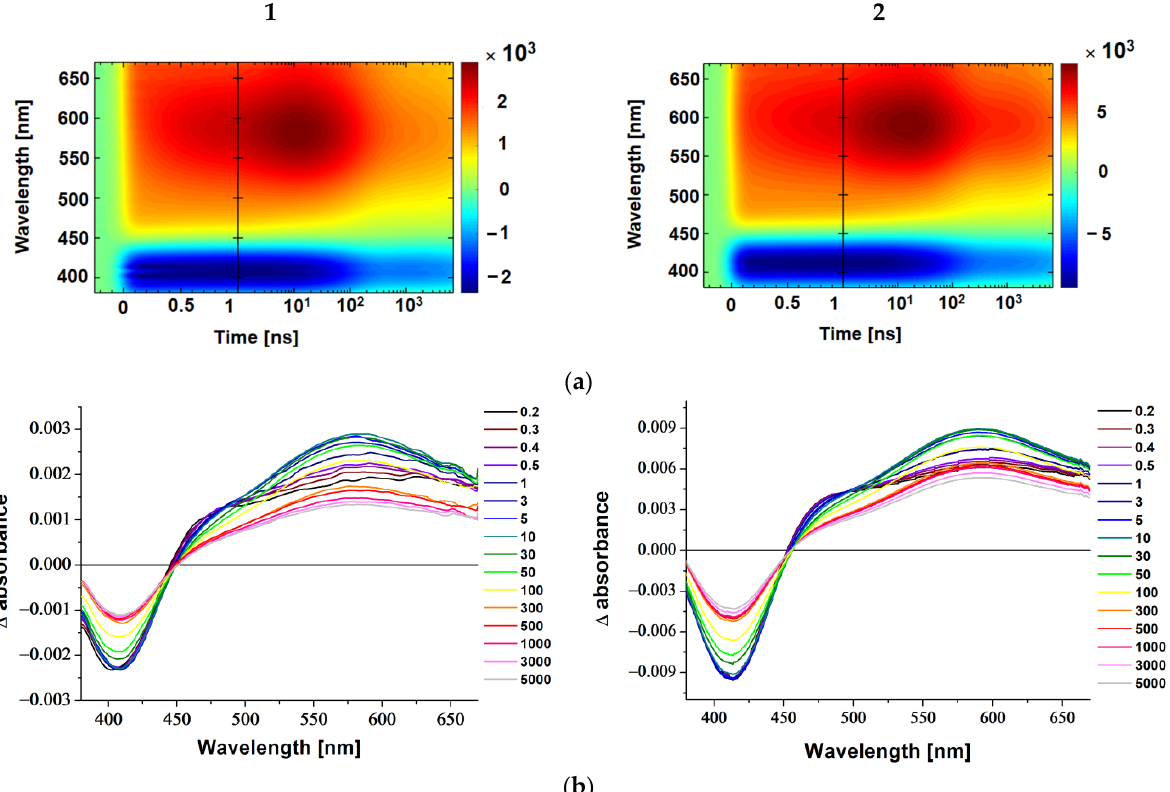
Figure 8. The fsTA 2D maps ( a ) and TA spectra at selected time delays ( b ) for complexes 1 and 2 in acetonitrile.